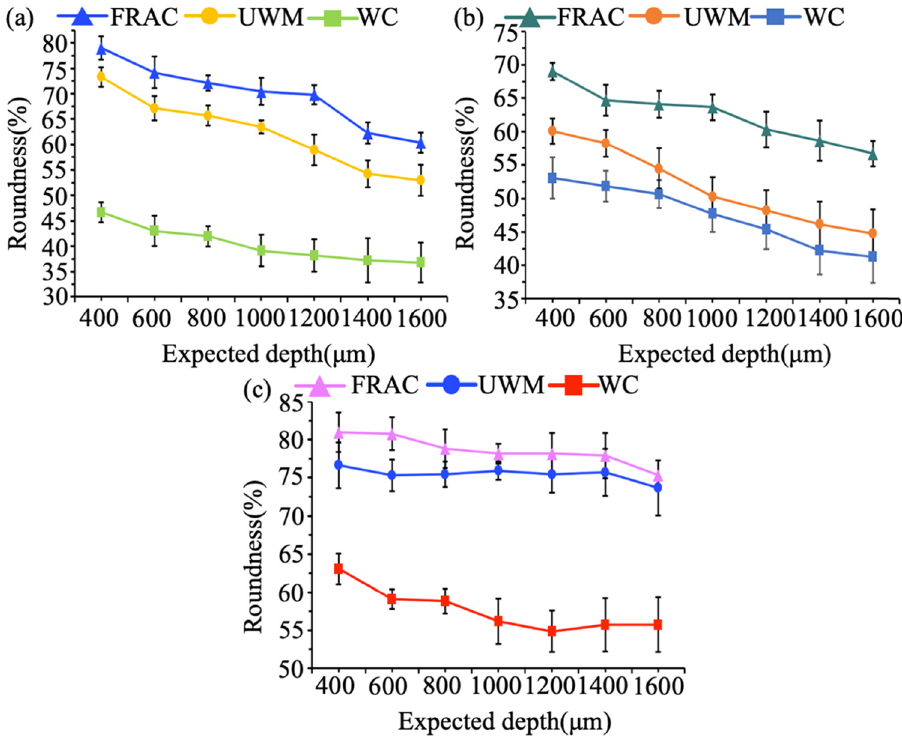
Figure 6: The roundness factor of blind holes; ( a ) tungsten steel electrode: ( b ) brass electrode; ( c ) copper electrode ( frequency = 130 kHz,